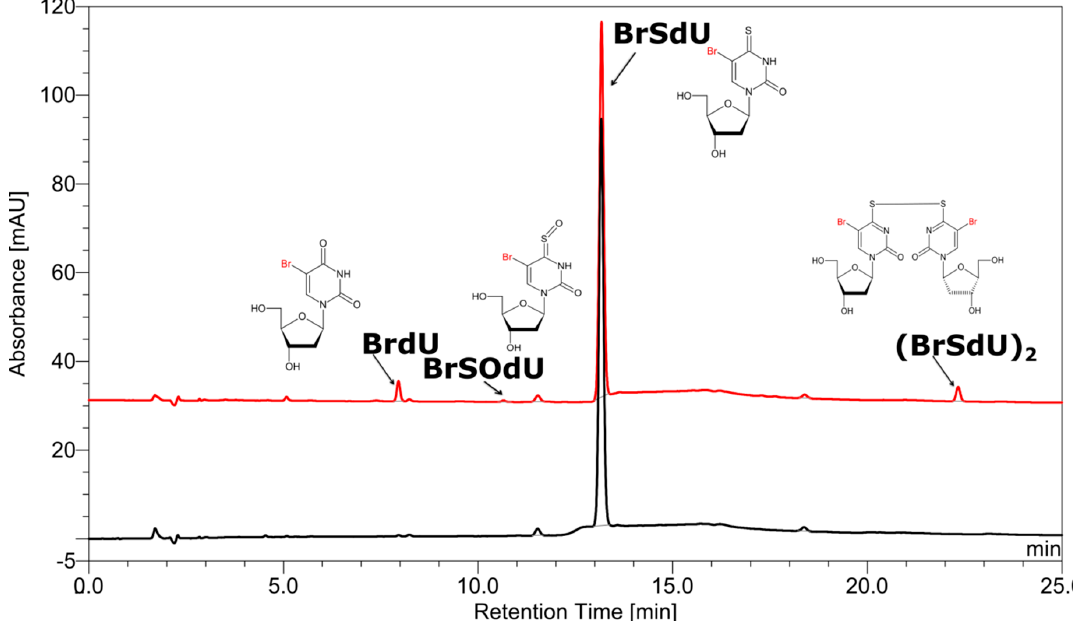
Figure 1. High-performance liquid chromatography (HPLC) traces for a solution of BrSdU before (black) and after irradiation (red). The chemical structures of products, as indicated by the liquid chromatography–mass spectrometry (LC–MS/MS) analysis, are depicted at particular peaks.